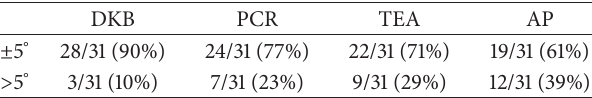
Table 2: Anatomic alignment ( ± 5 ∘ ): femoral component rotation relative to aTEA measured by CT using DKB method, PCR, TEA, and AP anatomic